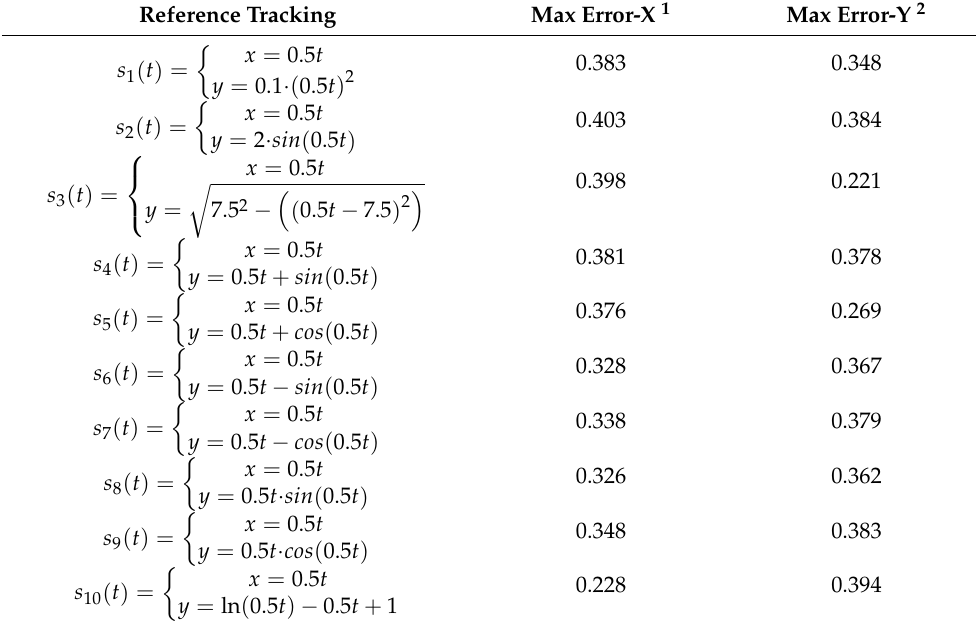
Table 1. Table of maximum absolute tracking error in each direction.